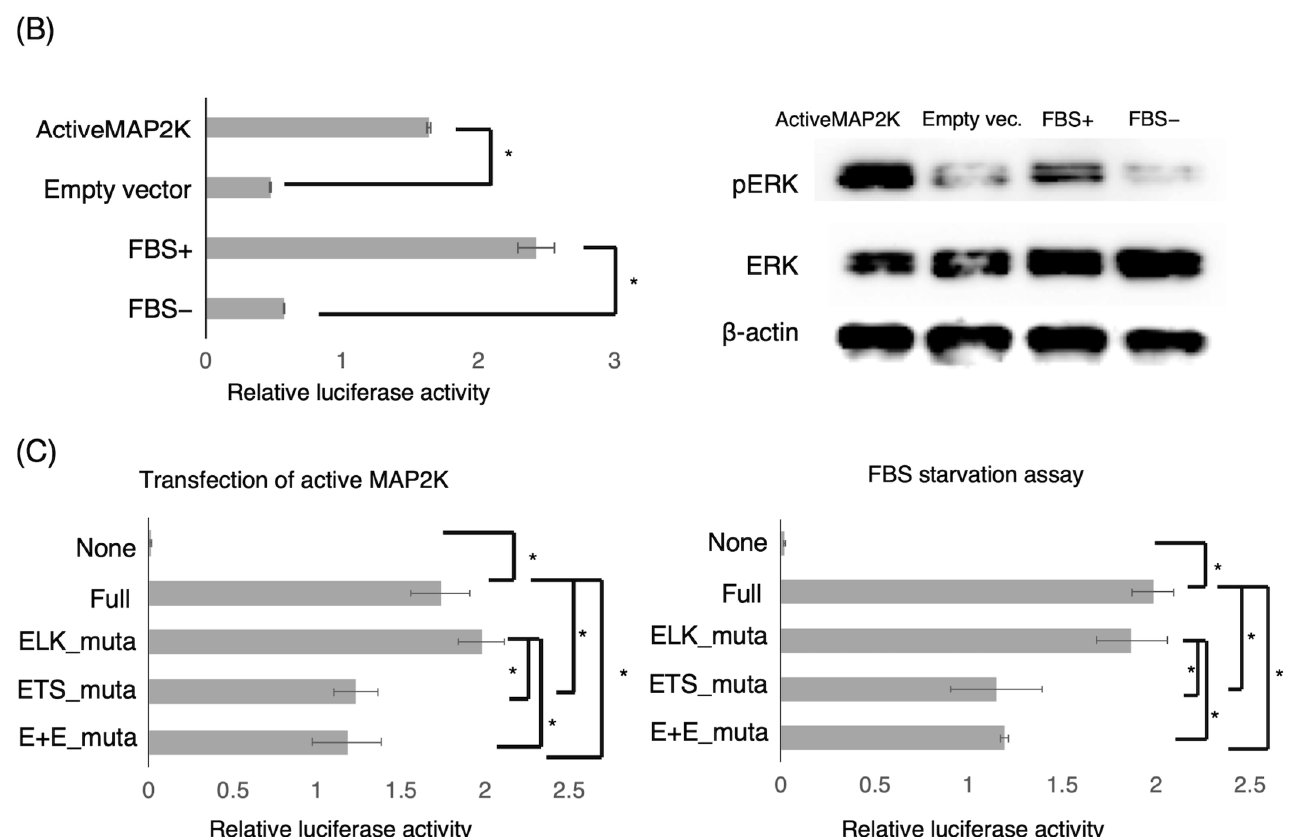
Figure 2. LINC00941 promoter activity is associated with MAPK activity. ( A ) A candidate promoter region of LINC00941 harboring consensus sequences of biding sites for ELK-1 and ETS-1. Arrows indicate relative positions of primers spanning the 3720-bp genomic region immediately upstream of exon 1 of LINC00941 used for construction of reporter vectors for the promoter assay. Mutagenic disruptions of the consensus binding sites used in experiments shown in ( C ) are indicated. ( B ) Reporter assays with modulation of MAPK activity. Left panel: the candidate promoter region reveals the promoter activity significantly associated with MAPK activity modulated by the active MEK/MAP2K transfection or FBS starvation in AsPC-1 (* p < 0.05). Right panel: Immunoblots showing